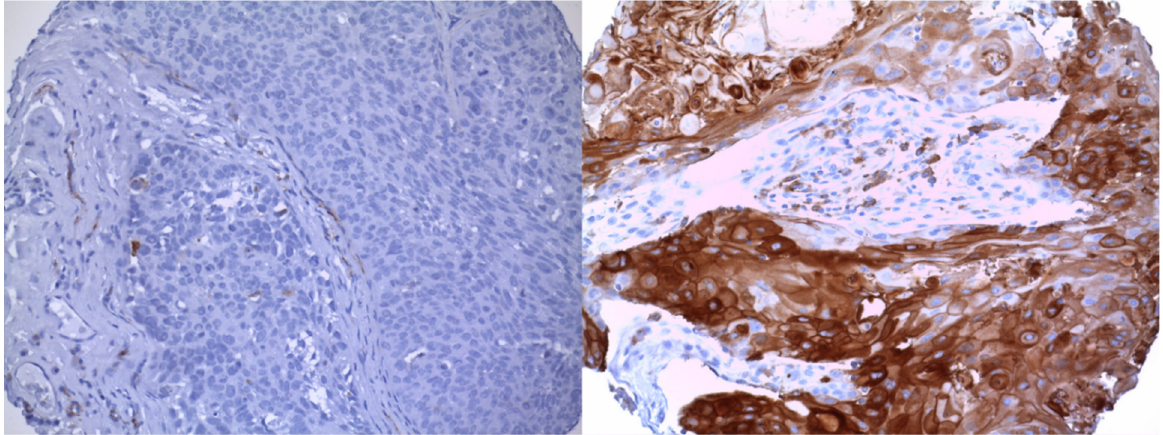
Figure 1. Tissue microarray stained for CD36. Representation of the immunoscoring classified; left low CD36 expression; right high CD36 expression. Magnification 20x.